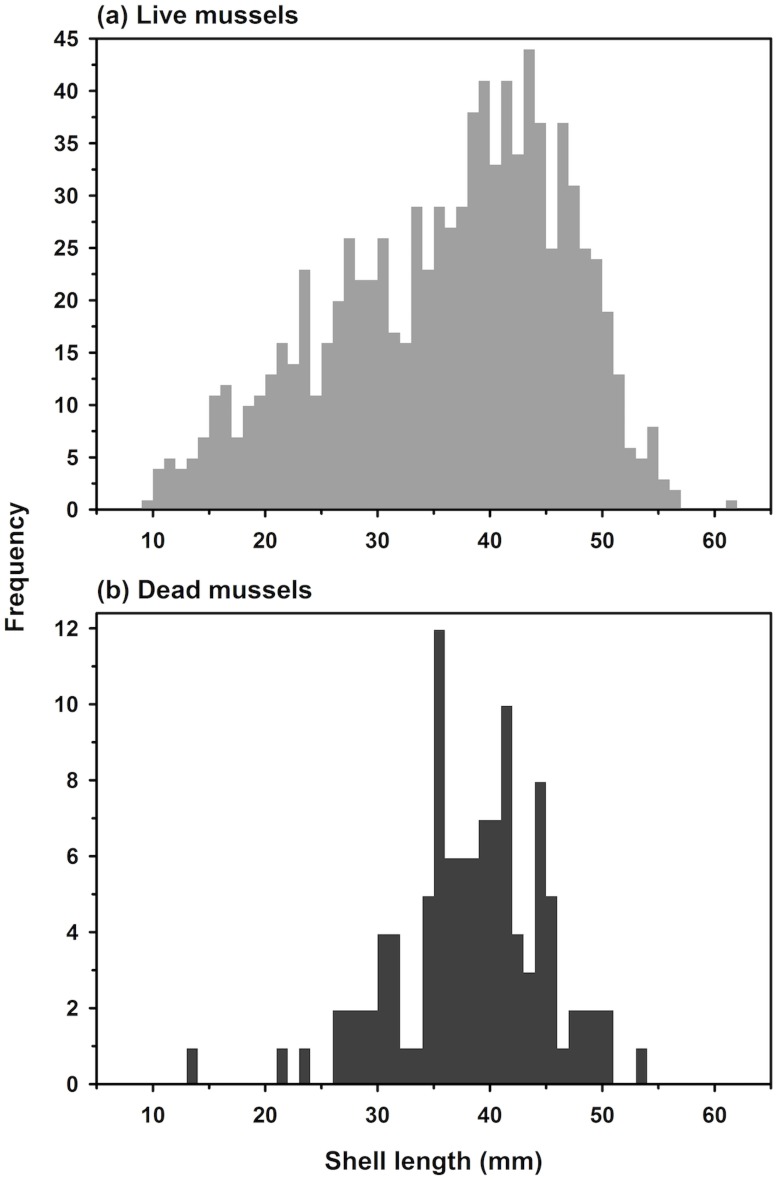
Size frequency of live (a) and dead (b) mussels on the modular reef.